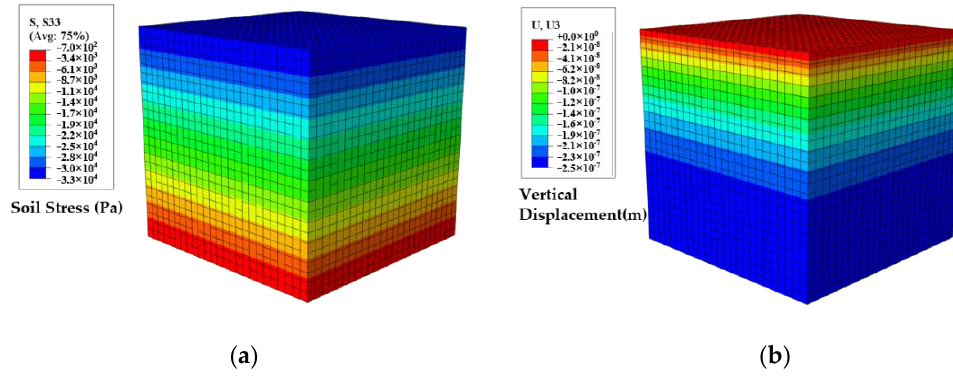
Figure 7. Simulation results of geostatic stress balance. ( a ) The soil stress distribution, ( b ) the soil vertical displacement distribution.